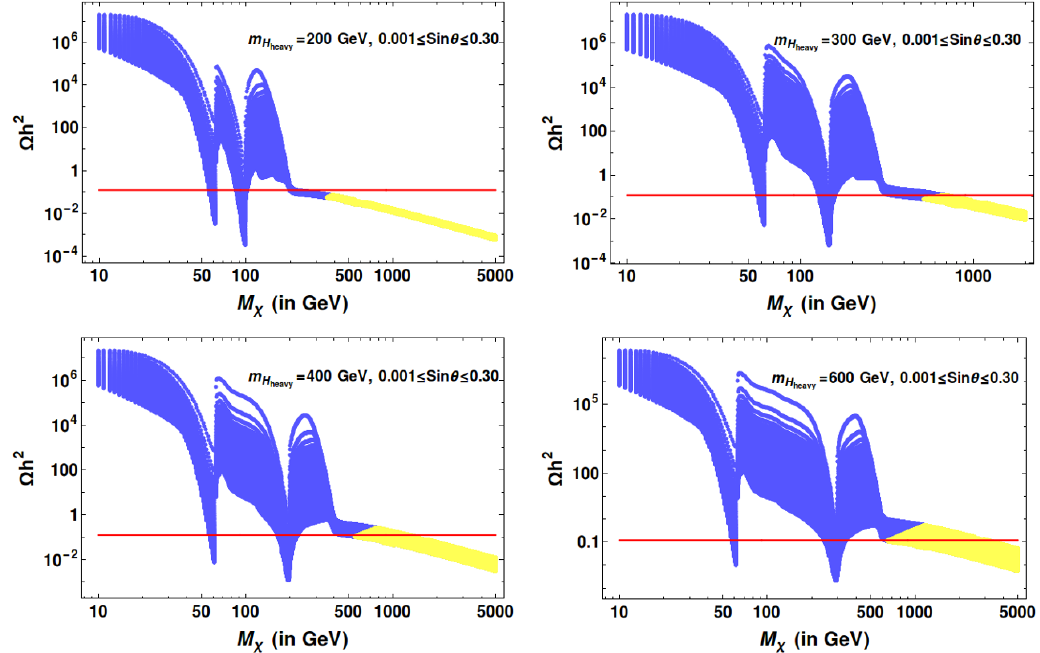
Figure 8 . Relic density ((cid:10) h 2 ) obtained as a function of DM mass ( M (cid:31) ) for three di(cid:11)erent choices of heavy Higgs mass: m H =200, 300, 400 and 600 GeV. Mixing angle is varied between 0 : 001 (cid:20) Heavy sin (cid:18) (cid:20) 0 : 3. Horizontal red band represents observed relic density by Planck data. The yellow region corresponds to y > 1 : 0 which may violate the perturbative